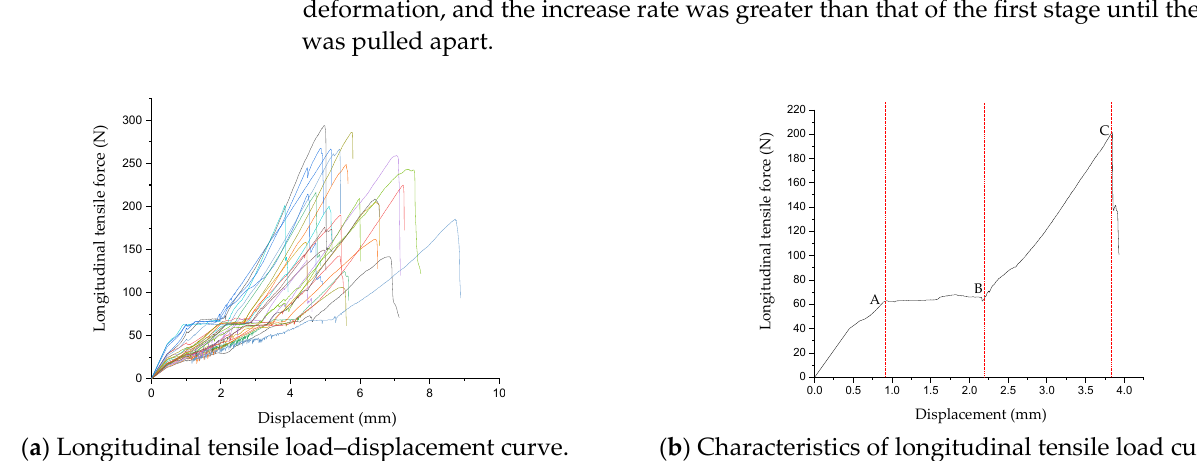
Figure 5. Longitudinal tensile test results: A is approximately the dividing point between elastic stage and yield stage; B is approximately the dividing point between yield stage and strengthening stage; C is the point of tensile strength.